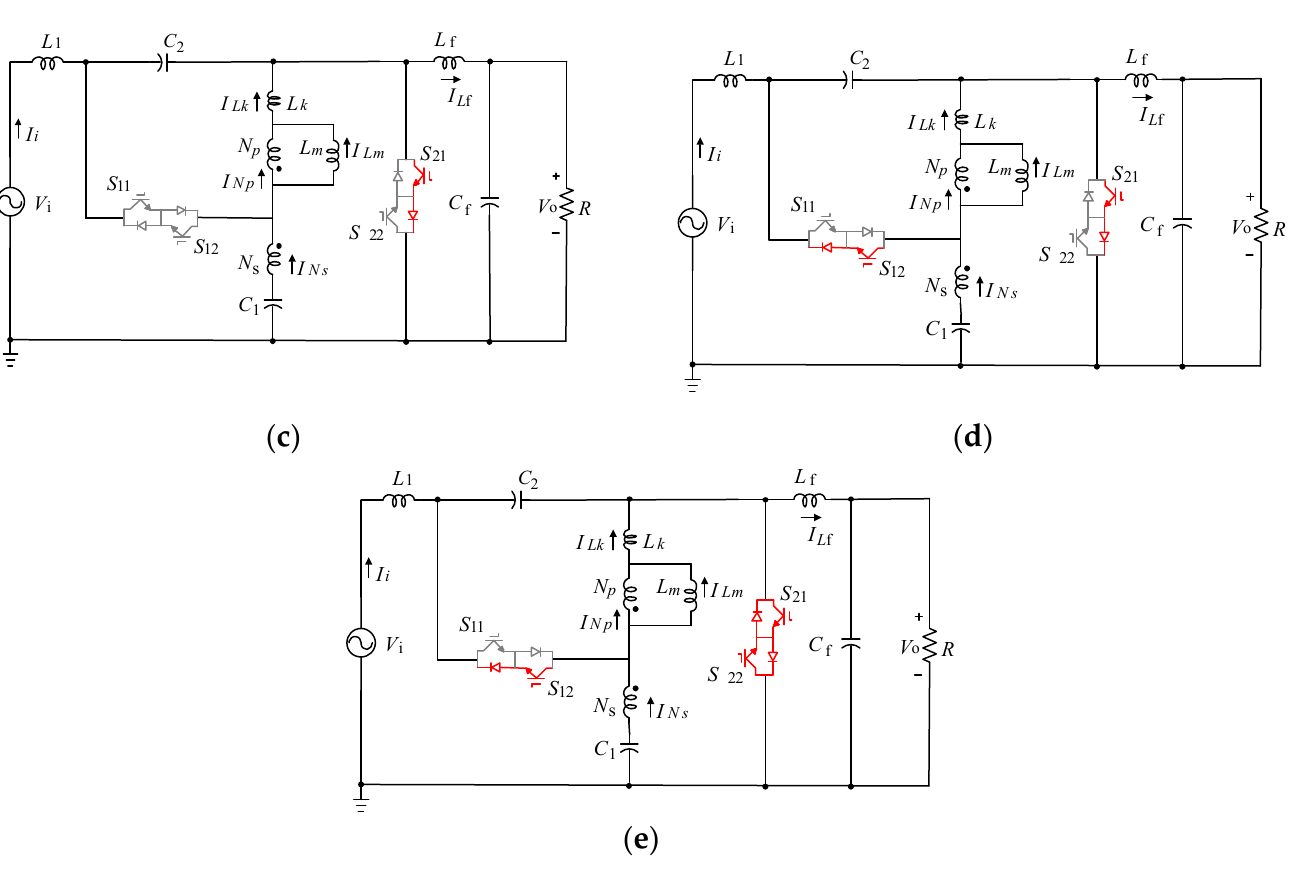
Figure 6. Operation intervals of the introduced topology for boost in-phase mode when V i < 0, ( a ): non-shoot-through state, ( b ): commutation state if I i + I lk − I lf < 0, ( c ): commutation state if I i + I Lk − I lf